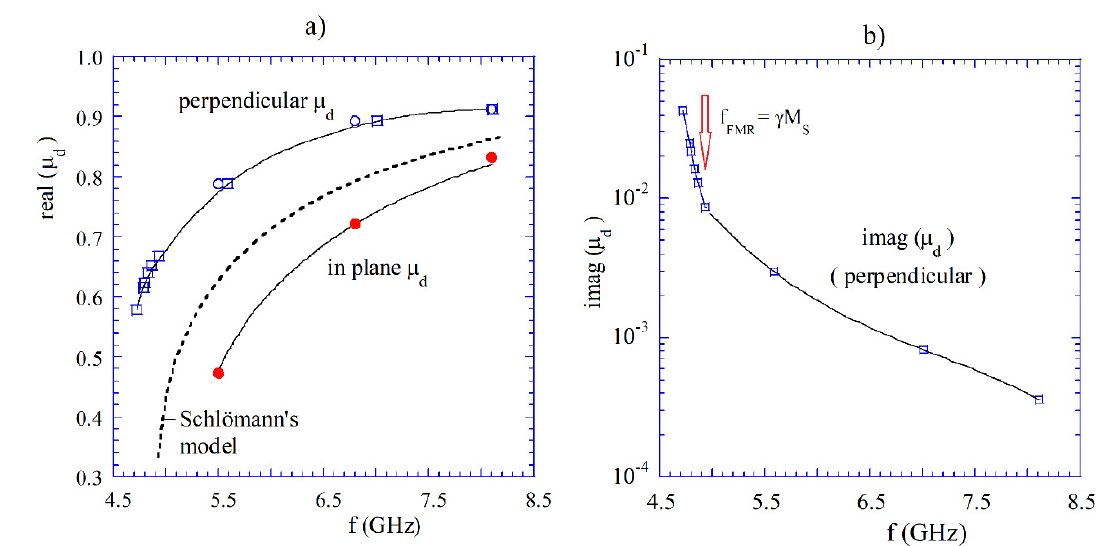
Figure 13. ( a ) The initial permeability of ceramic YIG substrates (thickness of 0.383 mm) measured with microwave field directions parallel and perpendicular to the surface of samples, employing split post and single post dielectric resonators [66]. ( b ) The imaginary part of the initial permeability perpendicular to the surface of the sample [66].